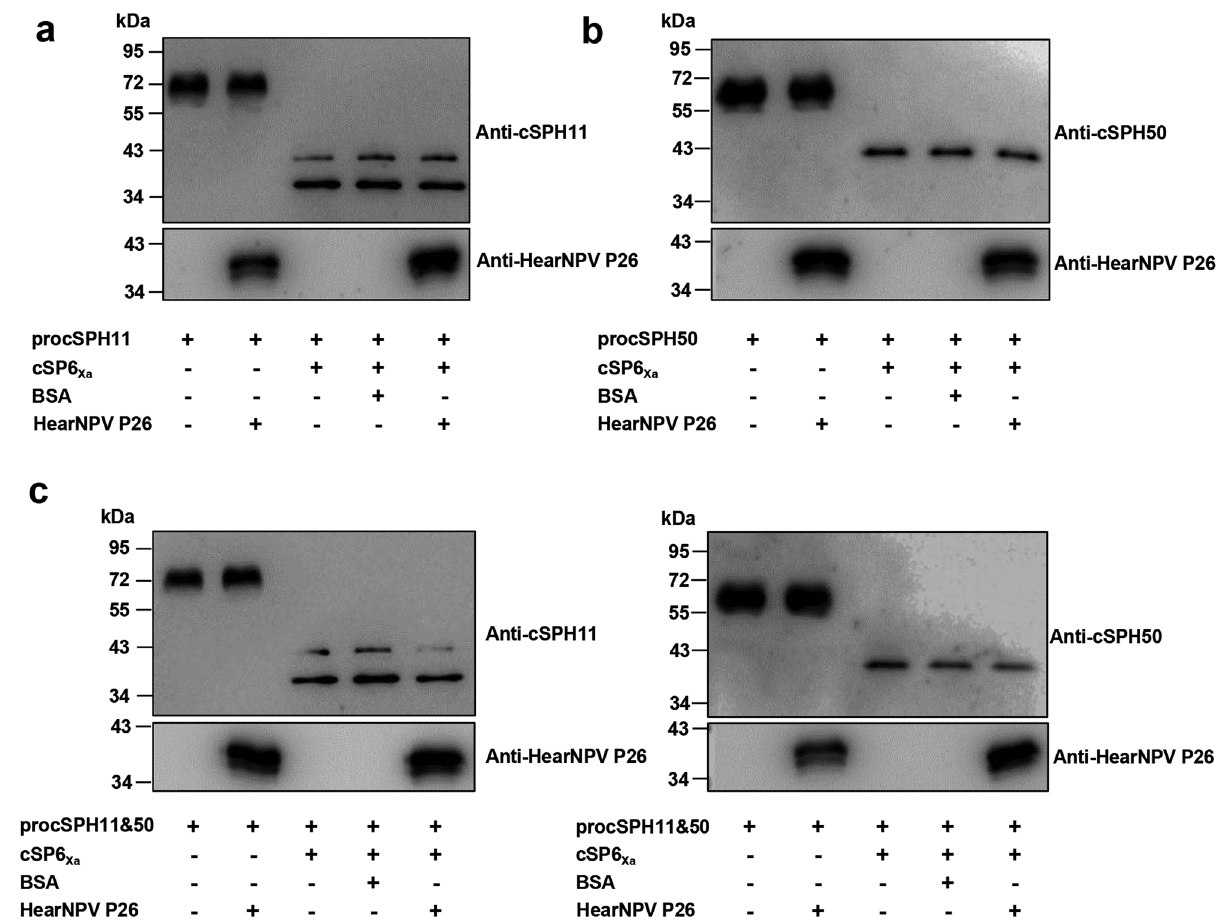
Fig. 4 | The impact of HearNPV P26 on the proteolytic cleavages of the serine protease homologs. cSP6 Xa was activated by Factor Xa before incubating with procSPH11 ( a ), procSPH50 ( b ), or procSPH11 and procSPH50 ( c ) for 1h. The